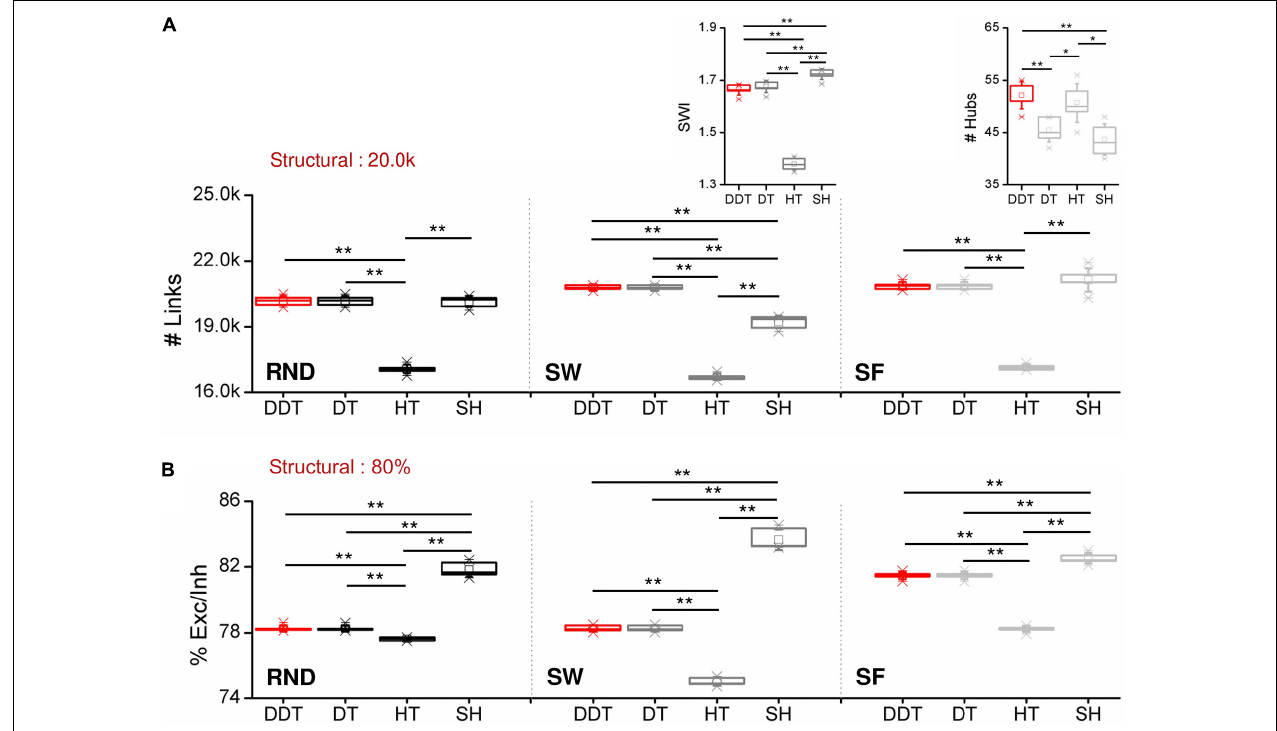
FIGURE 3 | Network features as a function of the considered thresholded methods. (A) Number of functional links and (B) ratio between excitation and inhibition for RND (right), SW (middle), and SF (right) networks. The insets in the middle and right panels of (A) show the distributions of the SWI and of the detected hubs in SW and SF networks, respectively (* p < 0.05, ** p < 0.01, Kruskal–Wallis, non-parametric